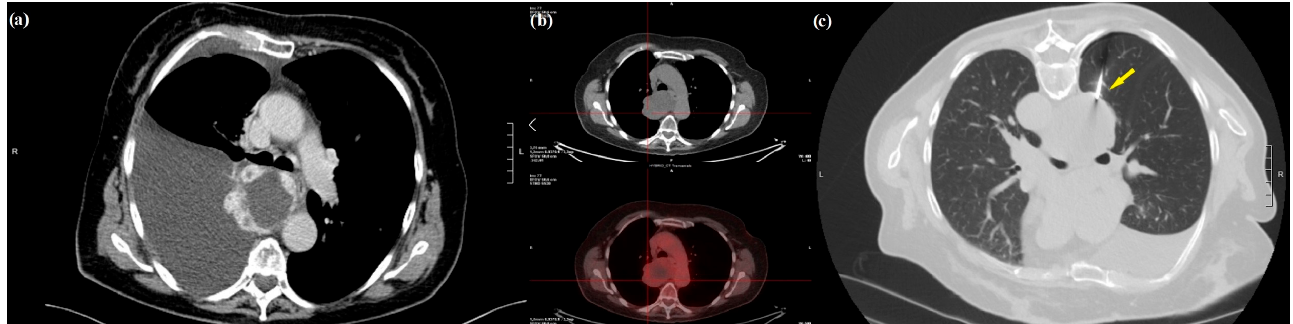
Figure 1. Preoperative diagnostic assessment: ( a ) chest CT scan showing a right pleural effusion and round-shaped mediastinal mass characterized by an irregular enhancing rim; ( b ) key image of FDG-PET/CT showing a delayed enhancement in the central mass and faint uptake in its periphery; ( c ) percutaneous CT-guided core needle biopsy of the mass (arrow) with a posterior approach. CT: computed tomography scan; FDG-PET/CT: 18-fluorodeoxyglucose positron tomography.